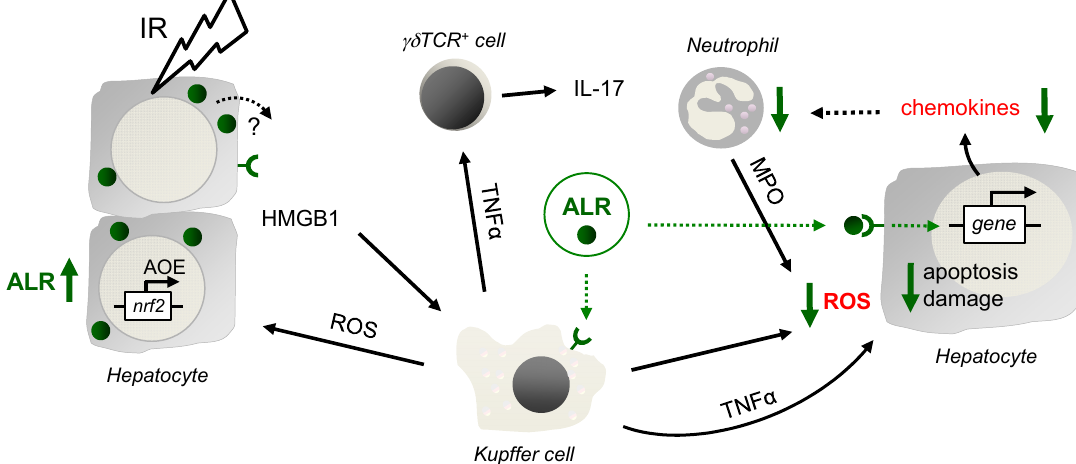
Figure 6. Schematic illustration of the findings. After IR, in the early phase of liver injury, activated Kupffer cells (KC) release reactive oxygen species (ROS), which stress and harm hepatocytes, leading to induction of anti-oxidative gene expression such as genes regulated by ROS sensitive transcription factor Nrf2. Nrf2 is known to regulate expression of genes harboring an anti-oxidative response element (ARE) in their promotor region, such as HO-1, GCLC, GPx and GST, but also ALR. In addition, hepatocytes release DAMPs (damage-associated molecular patterns), for example, HMGB1, which bind to Toll like receptor 4 on, for example, Kupffer and dentritic cells to propagate the inflammatory response, including TNF α expression and release. After IR, CD3 + cells are recruited to the liver, of which a subset are γδ T cells, activated by TNF α , among others, and upregulate and release IL-17 and IFN- γ . Application of ALR does not alter HMGB1 and TNF α expression in IR-injured mouse livers, although ALR receptors are described on hepatocytes and Kupffer cells. A potential impact of ALR on γδ T cell activity is not seen, since the expression and release of IL-17 and IFN- γ is almost unchanged. ALR reduces chemokine expression in IR injured livers and hepatocytes may be the responsible cell type. Therefore, the beneficial effect of ALR on IRI is most likely due to less oxidative stress by mitigating ROS generation in Kupffer cells and hepatocytes, reducing recruitment, but not activity of neutrophils (deliver ROS by MPO), which results in attenuated hepatocyte death and tissue damage.